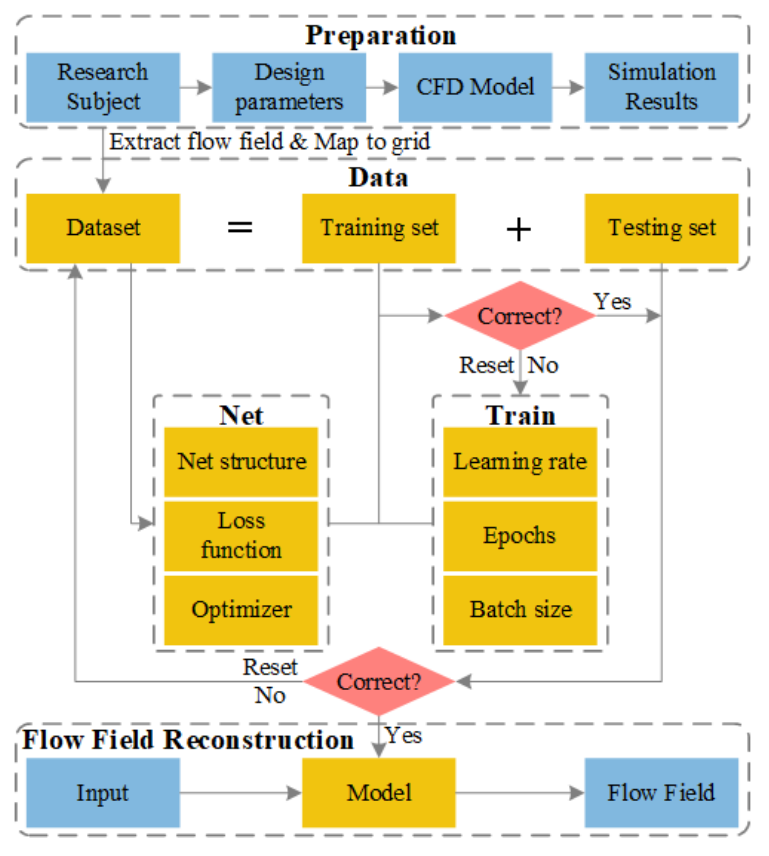
Figure 6. Process of deep learning flow field